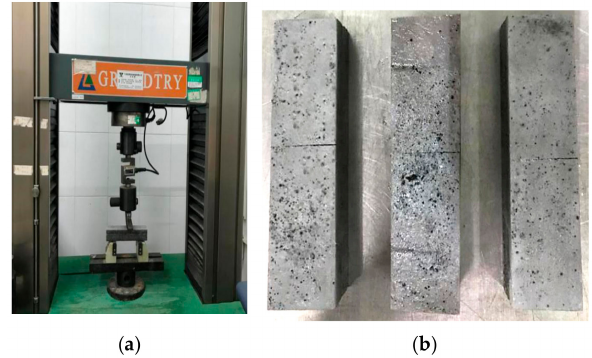
Figure 5. Preloading treatment of the specimens. ( a ) Preloading setup; ( b ) Preloaded specimens.